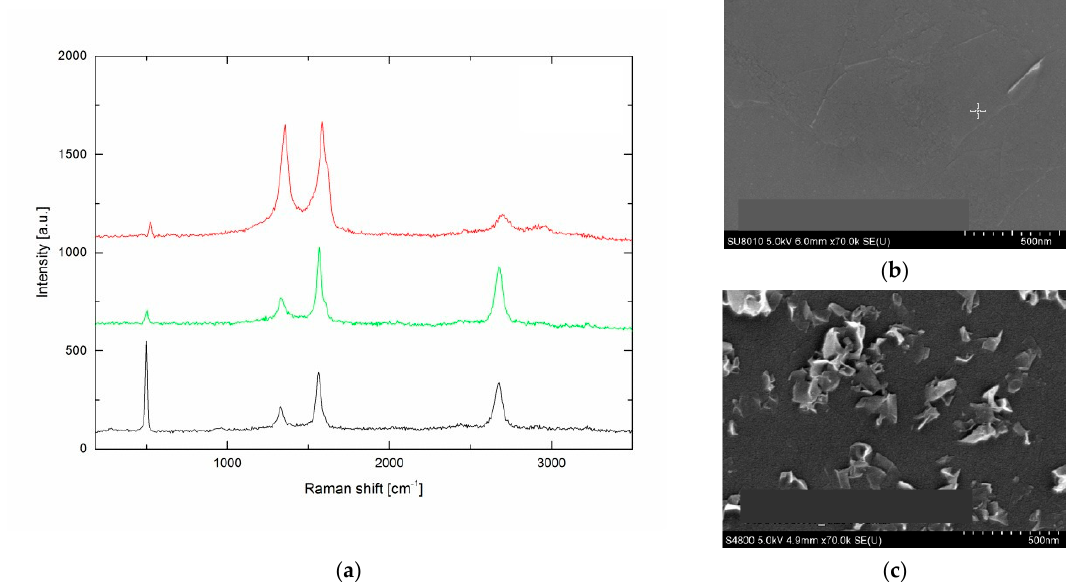
Figure 2. ( a ) Raman spectra of three different graphene flakes deposited using inkjet printing. The curve in red is the Raman spectrum of graphene flakes produced via electrochemical exfoliation. The curves in green and black are the Raman spectra of mono/two layers of graphene produced with a patented plasma process. ( b , c ) SEM pictures of graphene flakes produced with different methods: ( b ) few µm later size and few layer graphene produced by electrochemical exfoliation; ( c ) SEM picture of graphene flakes with small lateral size and mono/two layers of graphene produced with a patented plasma